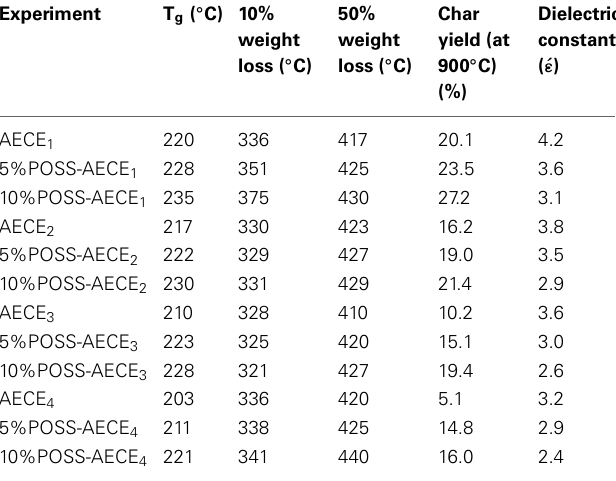
Table 2 | Thermal and dielectric properties of neat AECE and POSS-AECE